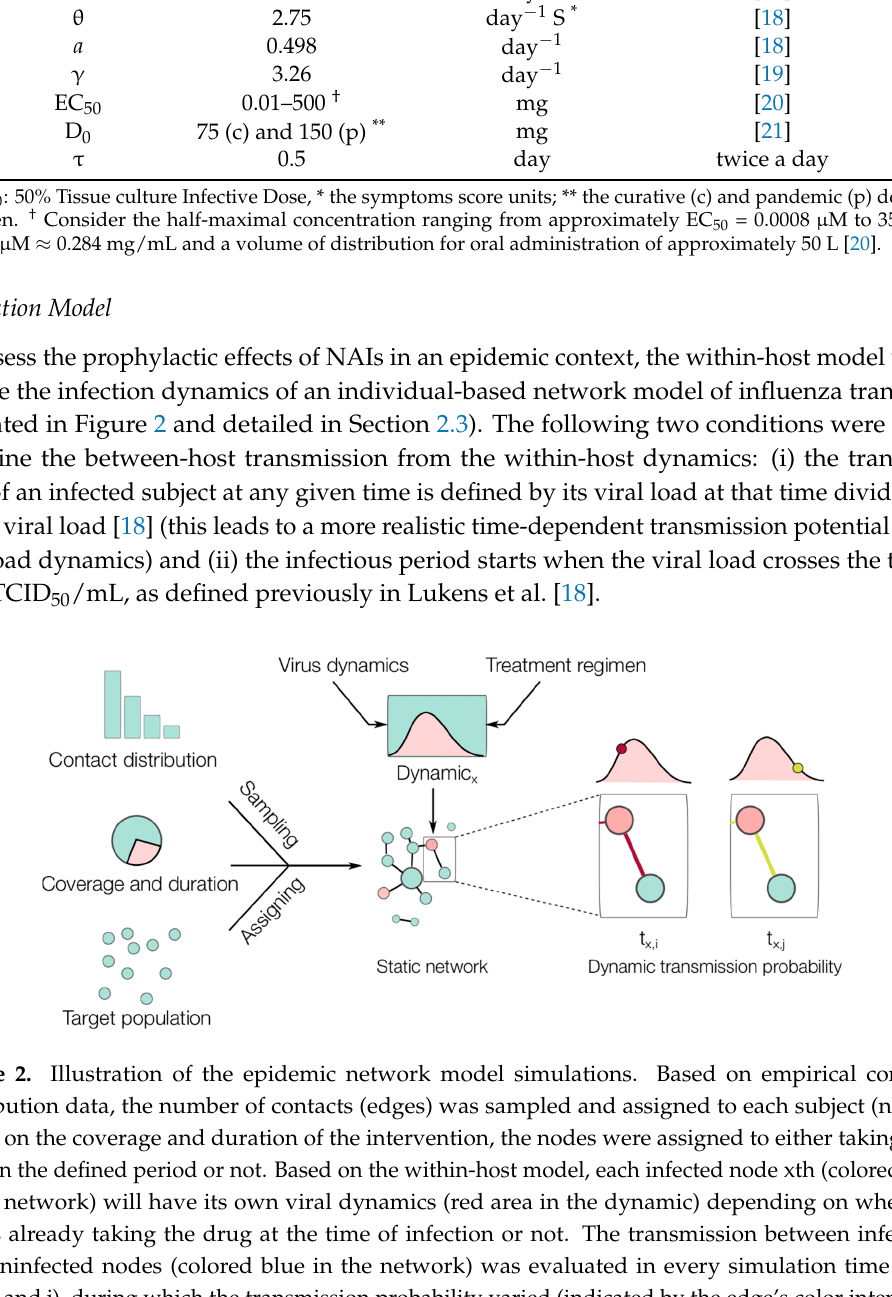
Table 1. Parameter values used in the simulations. The initial conditions corresponded to a susceptible cell population T(0) = 1 and an inoculum V(0) = 7.5 × 10 -6 TCID 50 mL − 1 .